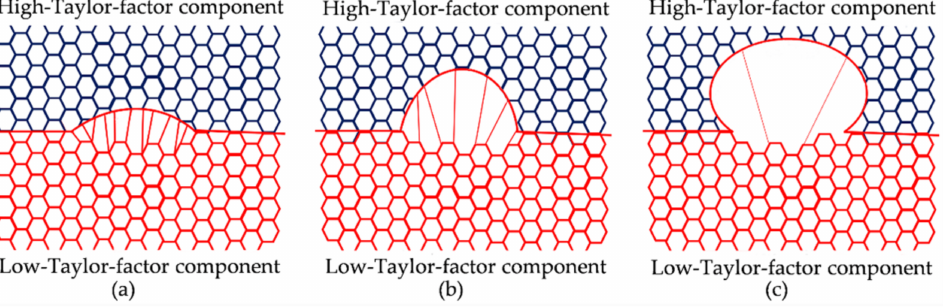
Figure 7. Schematic of the formation of SIBM with a boundary separating the high-Taylor-factor component and low-Taylor-factor component during hot deformation: ( a ) a bulge boundary forming with the dragging of the dislocation behind it, ( b ) a migrating bulge boundary accompanied by elongated dislocation with decreasing misorientation behind it, and ( c ) a DRX grain forming with few